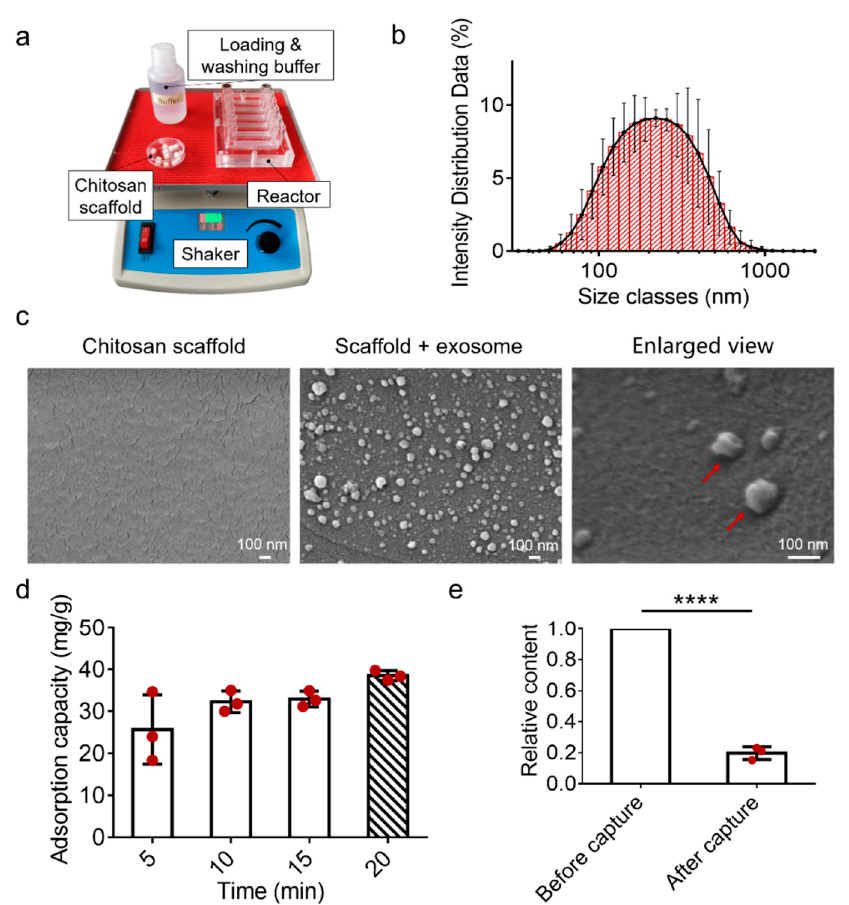
Figure 4. Characterization of the EV-sep device for exosome capture. ( a ) The device is composed of chitosan scaffolds, loading and washing buffer, a reactor, and a shaker, which provides shuttle flows. ( b ) Particle size analysis of standard exosome samples. ( c ) SEM images of chitosan scaffold before and after exosome capture. Red arrows show that particles with a size about 100nm and traditional exosome structure are absorbed on the surface of scaffolds. ( d ) Adsorption capacity of the chitosan scaffold for exosome capture. ( e ) The relative content of exosomes before and after adsorbed by the chitosan scaffold device. The data were present as mean ± S.D, n = 3. ****p < 0.0001 by two ‐ sided paired Student’s t test.